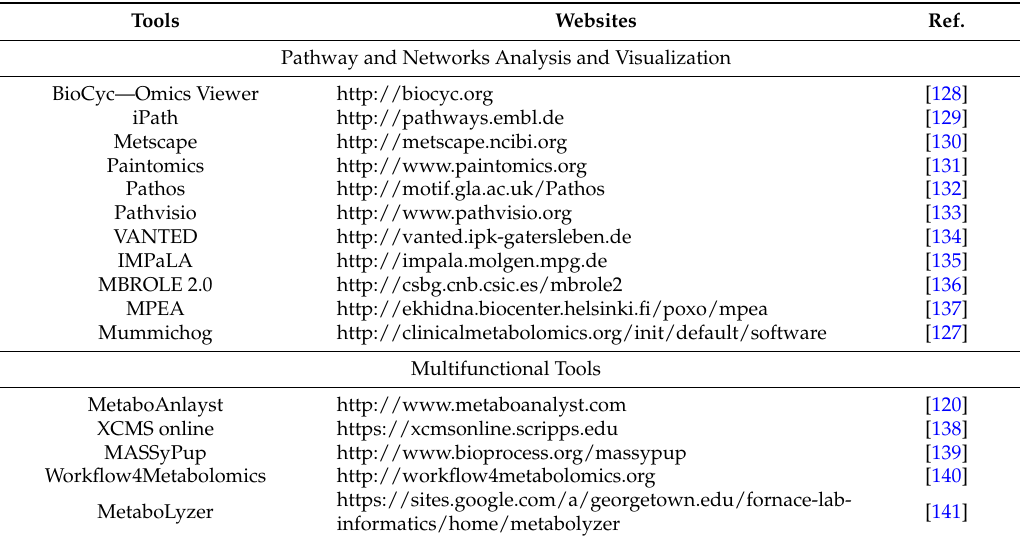
Table 3. Functional analysis and biological interpretation